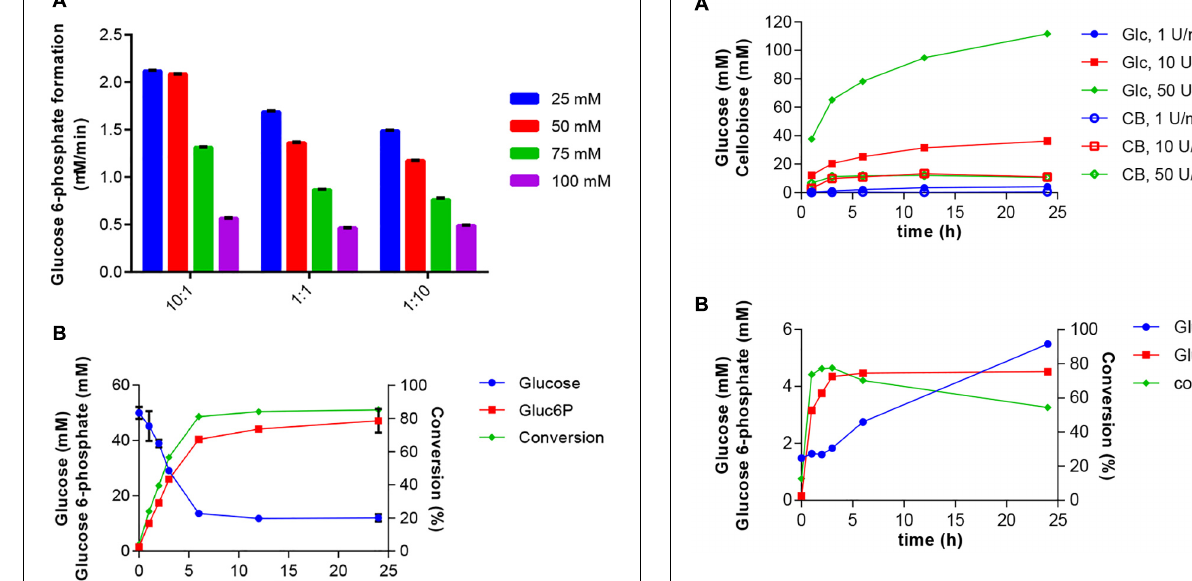
FIGURE 5 | One-pot synthesis of glucose 6-phosphate from cellulose. (A) Optimization of glucose release from 2% microcrystalline cellulose by A . niger cellulase at different enzyme concentrations. Glucose (Glc) and cellobiose (CB) accumulation were determined over a 24-h period. (B) Cellulase, HK and PPK2 activities were combined in a reaction containing 2% cellulose, 2 mM ATP and 50 mM polyphosphate. Reactions were incubated at 30 ◦ C and samples were taken at the indicated times. Produced glucose 6-phospate and remaining glucose were determined using HPAEC-PAD. Conversion indicates the fraction of glucose converted into glucose 6-phosphate. All data represent the mean and standard error of two or three replicates. If not visible, the error bar is smaller than the symbol